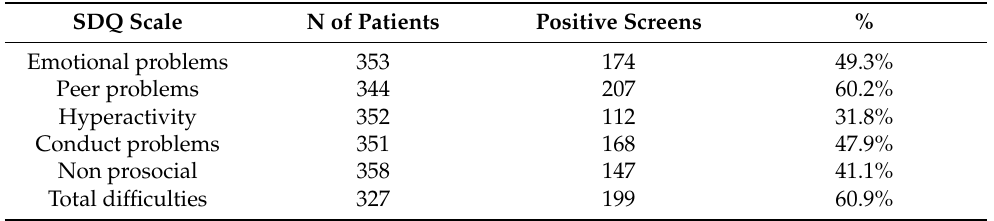
Table 2. Resultsoftheparent-reportSDQscreeninginaclinicalsampleofLatvianchildrenandadolescents. SDQ